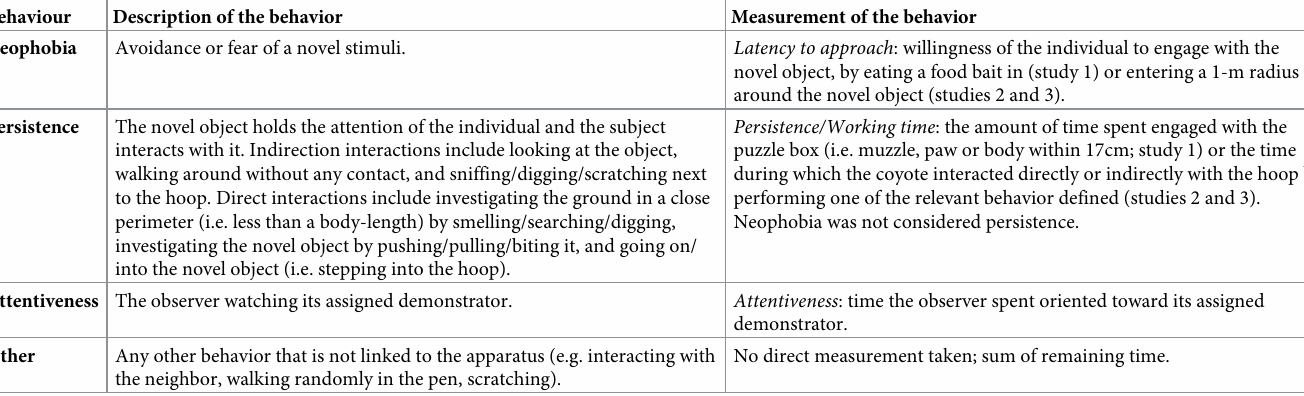
Table 1. Designation, description, and measurement of the behaviors observed during three studies on social learning in captive coyotes. Behaviour Description of the behavior